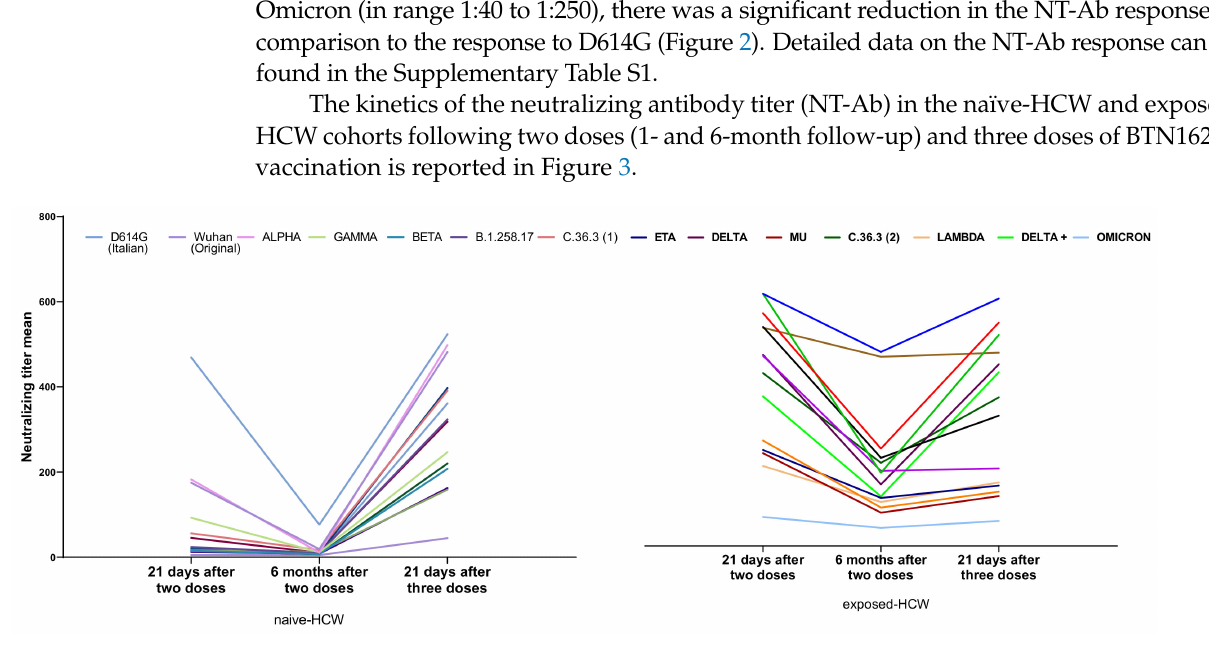
Figure 3. Data show the progression of the neutralizing antibody titer (NT-Ab) in the naïve HCW ( left ) and exposed-HCW cohorts ( right ). In both groups, there was a reduction in the NT-Ab at 6 months post-2nd dose, but the titer was recovered at 1 month after the 3rd